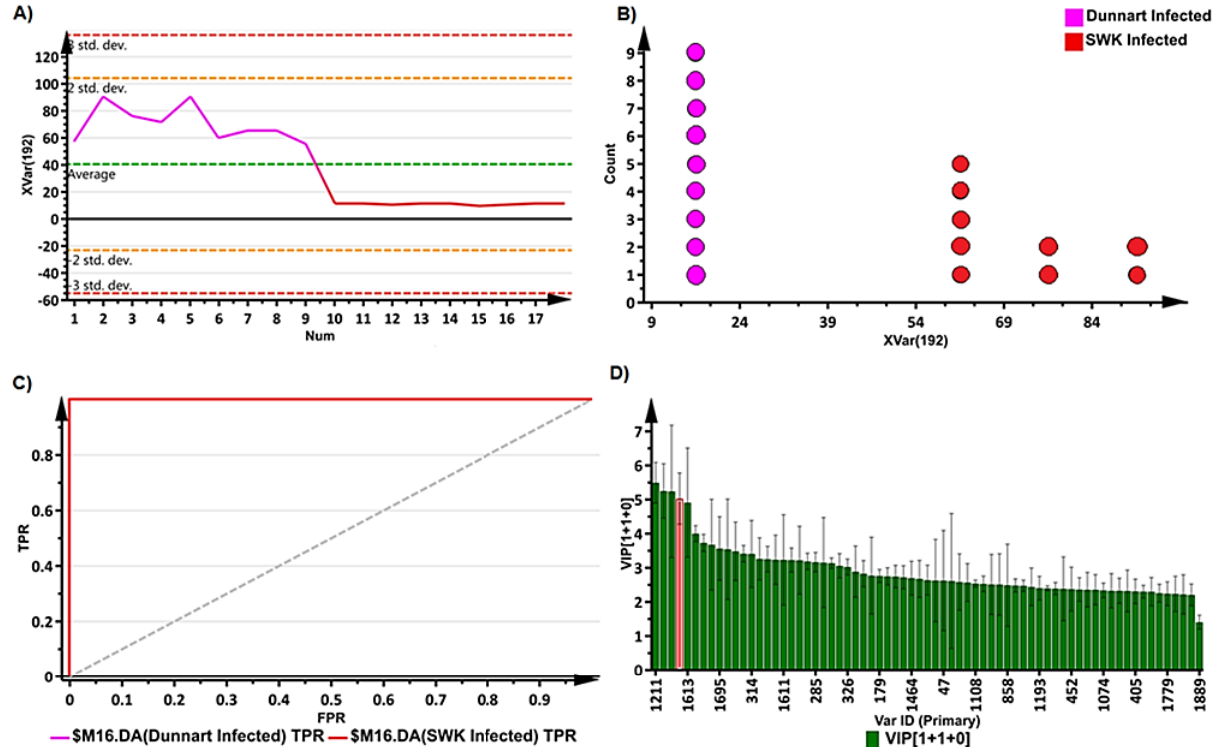
between the control and infected “Dunnart” groups at 4 d.p.i. based on their leaf-extracted metabolic profiles obtained in ESI(–) MS mode (R 2 = 0.999, Q 2 = 0.995, CV-ANOVA p -value = 1.89349 × 10 − 15 ). ( B ) OPLS-DA scores plot illustrating the relationship among the infected “SWK001” and “Dun- nart” plants at 4 d.p.i. based on their leaf-extracted metabolic profiles obtained in ESI( − ) MS mode (R 2 = 0.999, Q 2 = 0.996, CV-ANOVA p -value = 1.06365 × 10 − 14 ). ( C ) The corresponding OPLS- DA loadings S-plot of ( A ). The pink and green circles indicate the values situated far out [1] ( p > 0.05, < − 0.05 and p (corr) >0.5, < − 0.5) in the S-plot, representing statistically significant ions that are possible discriminatory variables between the control and infected “Dunnart” groups. ( D ) The corresponding OPLS-DA loadings S-plot of ( B ). The pink and red circles indicate the values situated far out [1] ( p > 0.05, < − 0.05 and p (corr) >0.5, < − 0.5) in the S-plot, indicating statistically significant ions that are possible discriminatory variables between the infected “SWK001” and “Dunnart” plants. The green circle indicates the selected variable (avenanthramide A) for which validation models are shown in Figure 5.